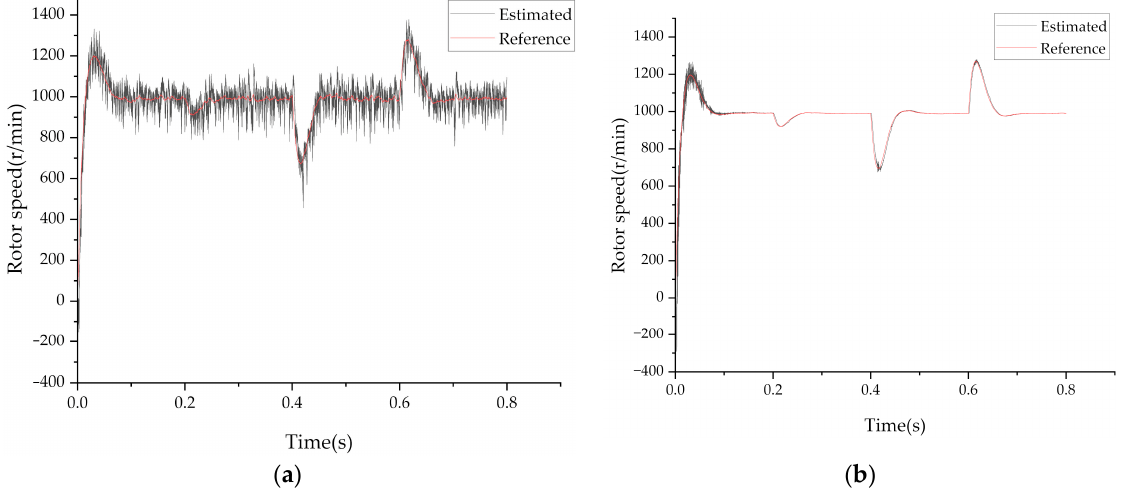
Figure 8. Experimental results of rotor speed. ( a ) Traditional SMO, ( b ) new SMO.